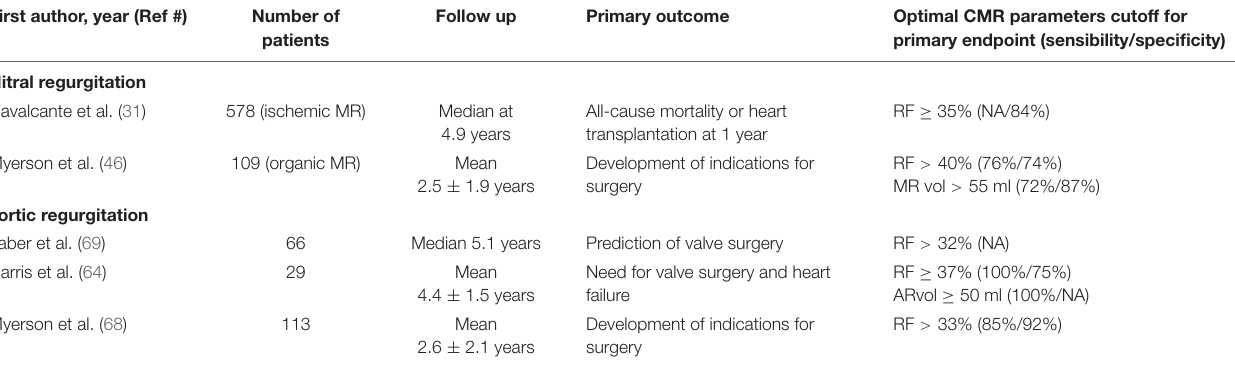
TABLE 6 | Relevant studies assessing prediction of outcome of severe MR and AR assessed by